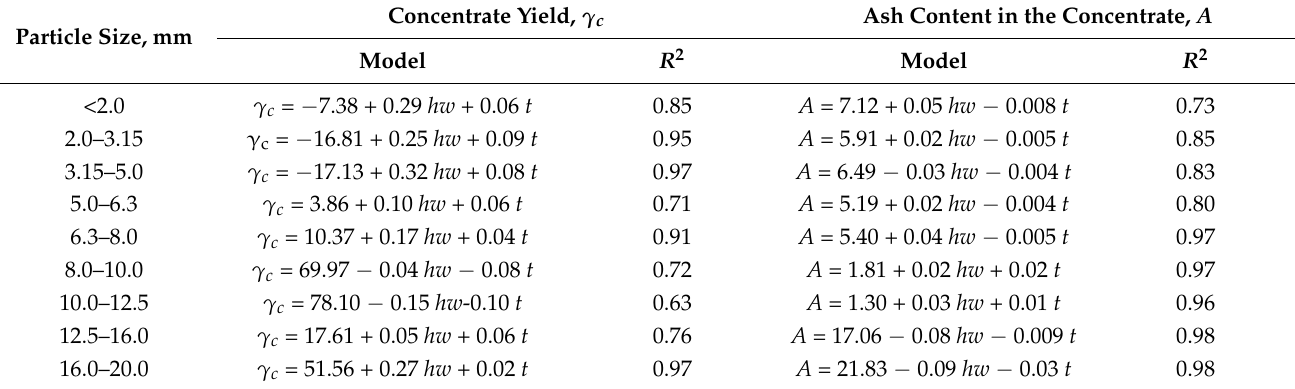
Table 2. Models specified for each particle size.